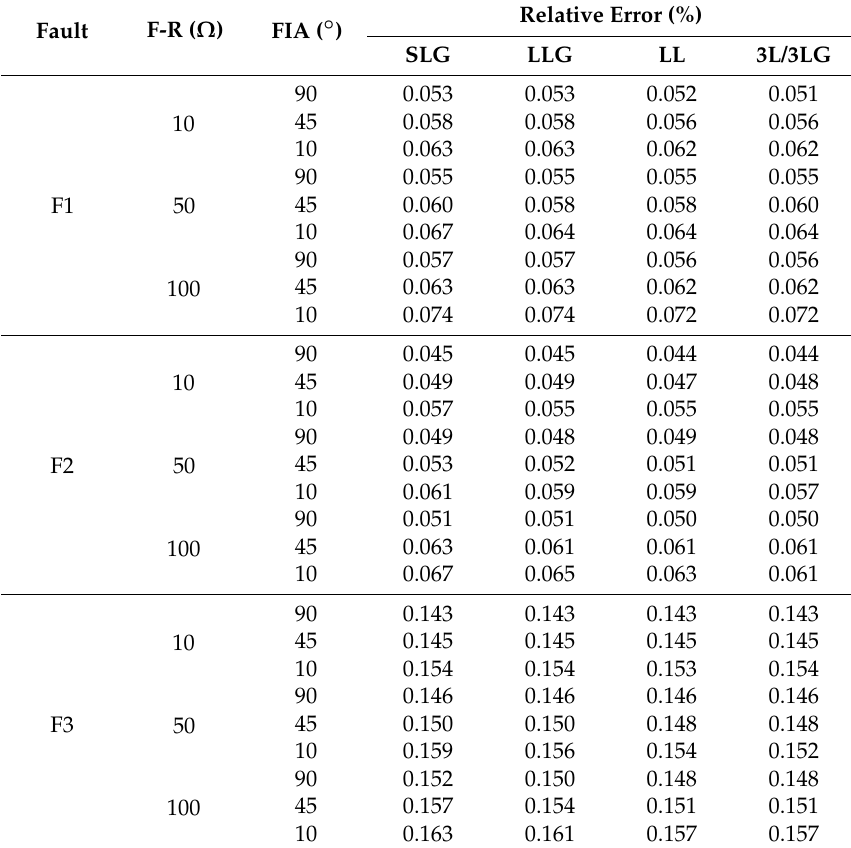
Table 7. Results of fault location for different